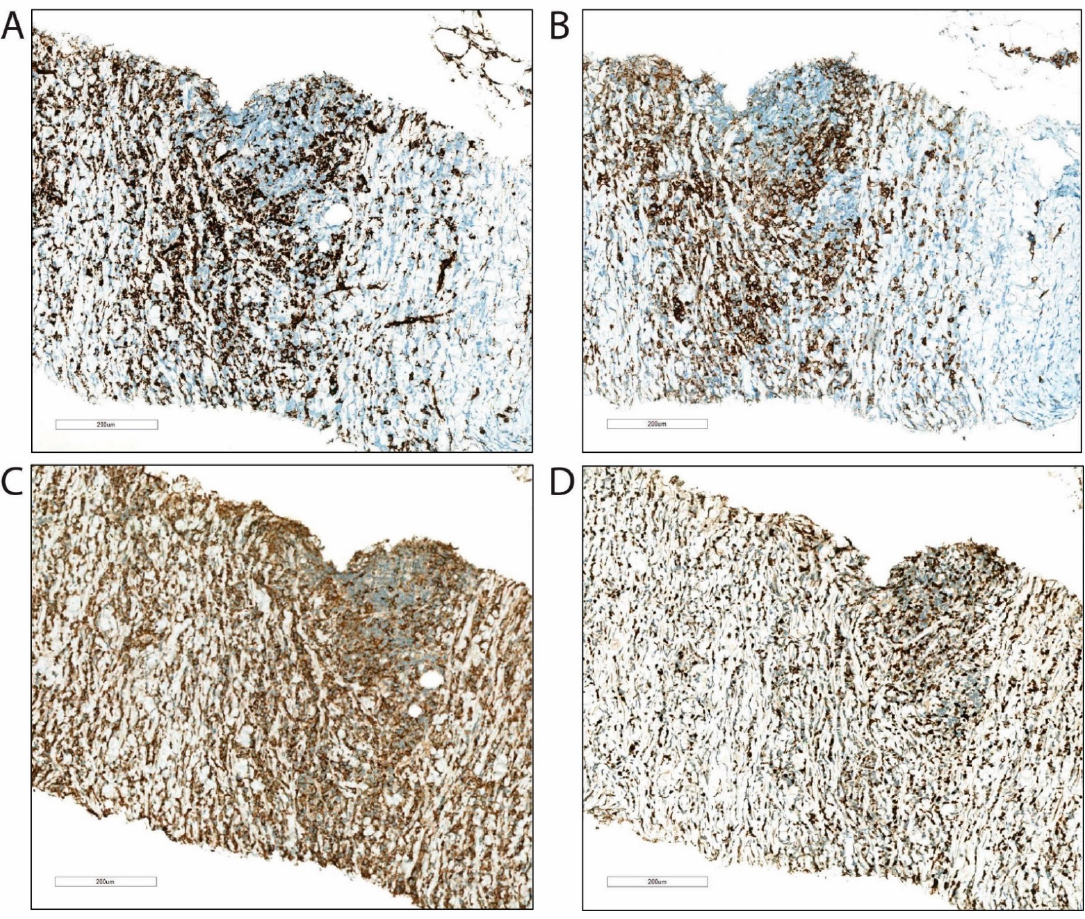
Figure 5. Immunohistochemical examination of the biopsy from the retroperitoneal tumor masses. ( A ) The majority of the tumor cells stained positive for myeloid stem cell markers CD34 ( B ) and CD117, ( C ) and for markers associated with cells of myeloid origin, myeloperoxidase ( D ) and lysozyme. Proliferation marker Ki-67 (MIB1) demonstrates high cell prolifer- ation. A 10 F pyelostomy catheter was placed to decompress the kidney, and then treatment was initiated using the standard AML protocol of idarubicin and cytarabine (the 3 + 7 regimen) [5]. Within one week after chemotherapy initiation, creatinine levels were nor- malized, and the pyelostomy catheter was removed. No signs of tumor lysis were ob- served. After the first induction cycle, the patient exhibited complete remission, defined as normalization of hematological parameters without transfusions, and bone marrow blasts <5% [5]. Consolidation treatment was administered with three consecutive cycles of high-dose cytarabine [6]. A new FDG-PET/CT after the end of treatment confirmed the treatment success, showing metabolic regression of the masses in the retroperitoneum (Figure 6), and regression of the myeloid sarcoma at the abdominal wall. At 12 months after diagnosis, the patient is currently in complete remission, without signs of kidney failure.